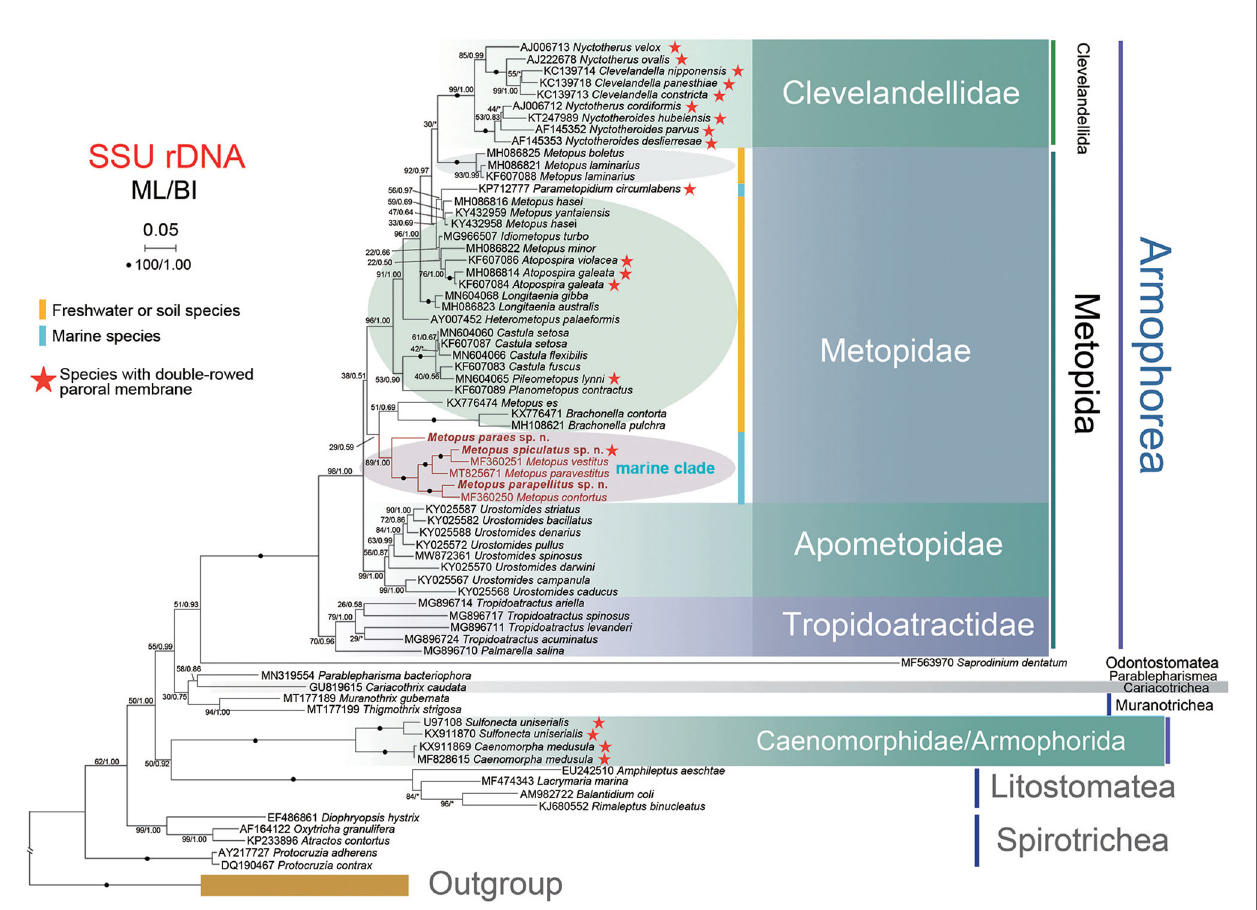
FIGURE 8 | Phylogenetic tree based on SSU rDNA sequences. The tree was constructed by the maximum likelihood method in RA × ML (GTRGAMMAI model). The values at branches represent support in bootstrap values (maximum likelihood method)/posterior probabilities (MrBayes method). New sequences in bold. Yellow bars represent freshwater or soil ciliates in Metopidae. Blue bars represent marine ciliates in Metopidae. Red stars mark ciliates with double-rowed membrane in Armophorea. Asterisks (*) re fl ect disagreements in topology between BI and ML trees. The scale bar represents 5 changes per 100